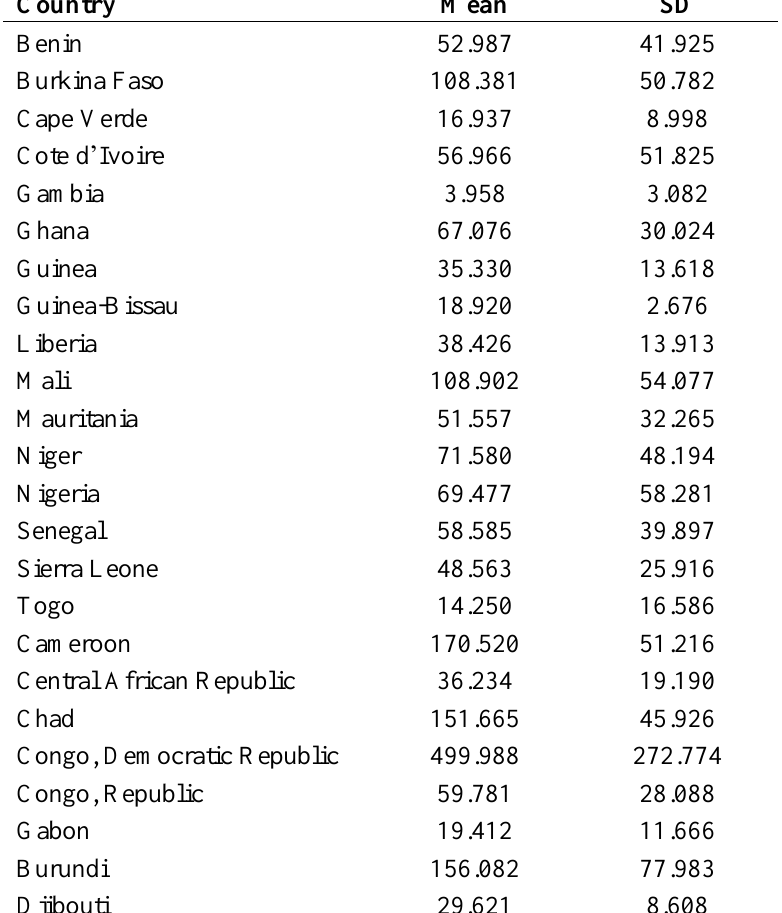
Table B2. Mean and standard deviation (SD) for aid flows per